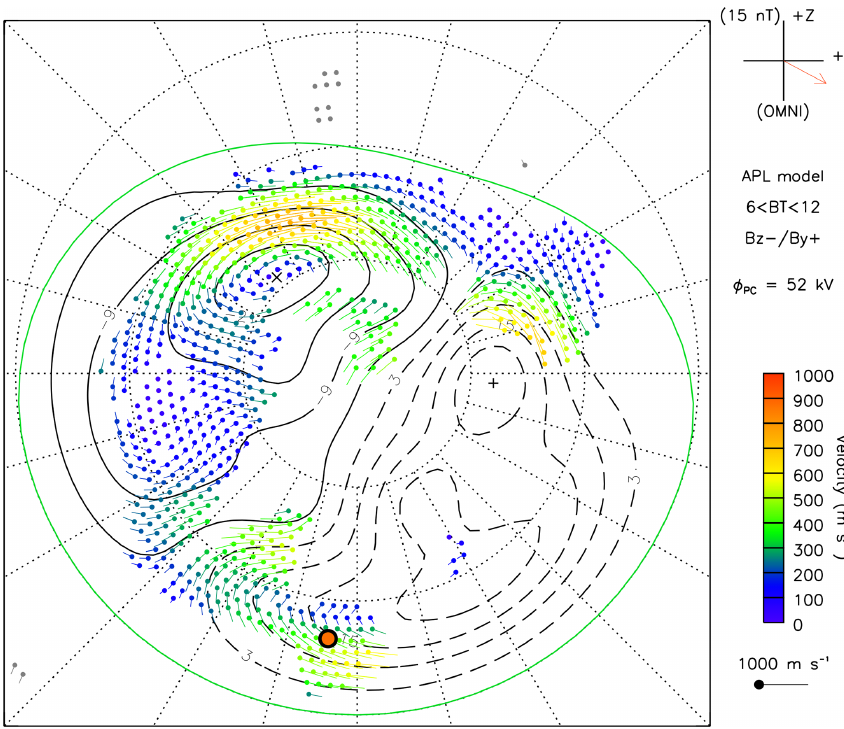
Figure 10. The large-scale pattern of flow vectors between 21:24 and 21:26UT on 9 November 2006. The position of the ASK instrument is marked with the orange